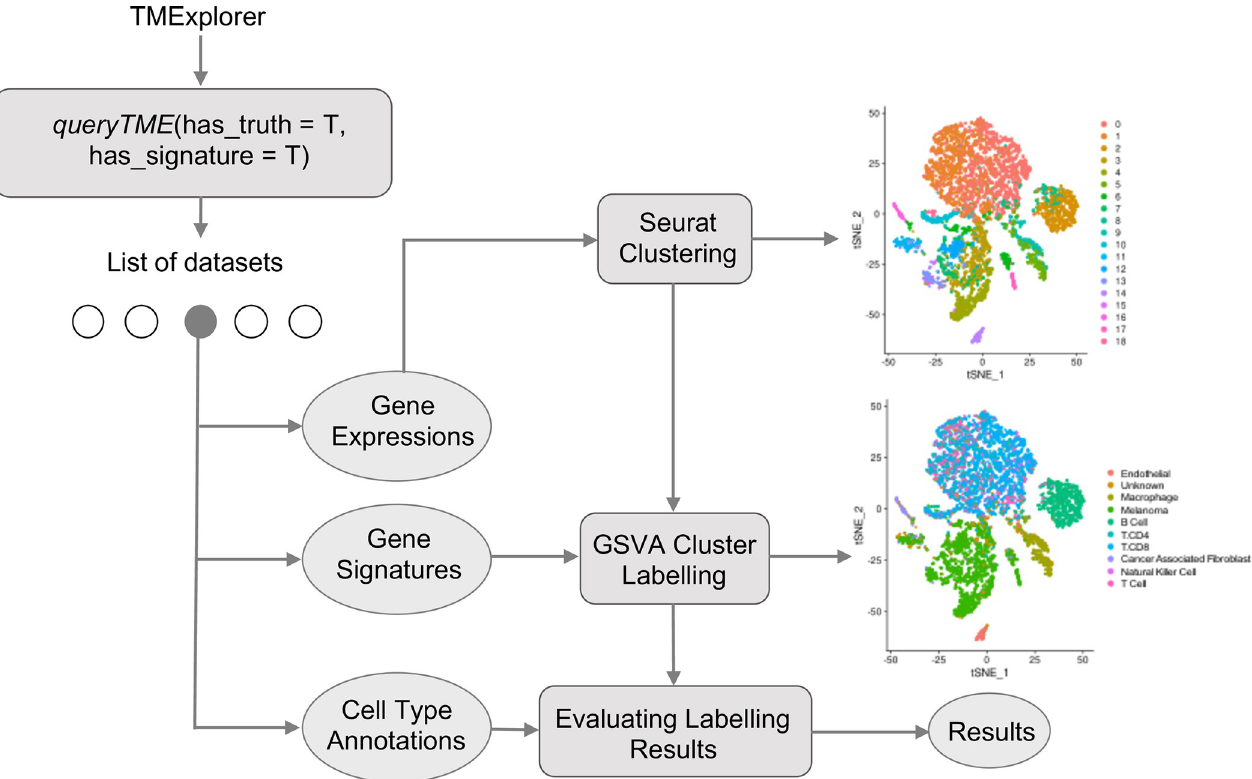
Fig 7. A case study on using TMExplorer to identify cell types. A case study showing how TMExplorer can be used in order to obtain datasets for cell cluster labelling via Seurat and GSVA. queryTME can be used to return those datasets which have both gene signatures and cell type annotations required for testing the automated identification of cell types. The expression data can be passed to Seurat for cell clustering, and the gene signatures can be used by GSVA to identify the cell types in Seurat’s clusters. Finally, the cell type annotations can be used as the truth labels to measure the performance of the results obtained by Seurat clustering followed by